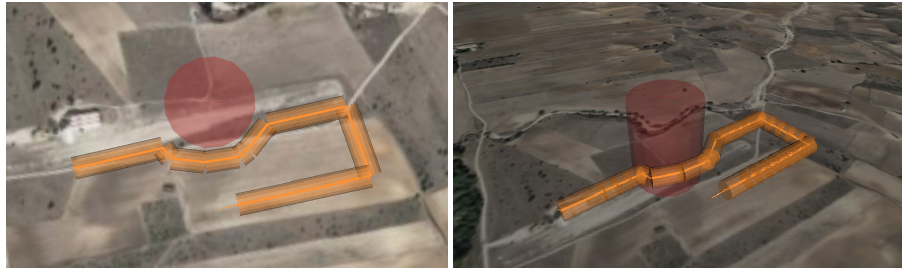
Figure 18. ( Left ), top view with the initial flight plans in the use case 2. The Operational Volumes without conflicts are also shown. ( Right ), situation after the detection of the jamming attack. A ge- ofence (in red) is created around the attacked UAS, which generates a conflict with the flight plan of the other UAS.